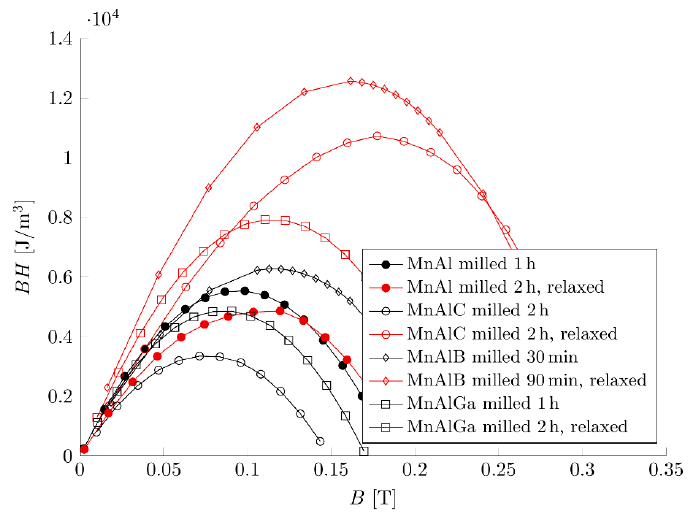
Figure 2. Energy product (BH) curves of MnAl and C-, B-, Ga-doped MnAl. The black lines are milled samples, and the red lines are milled and relaxed samples. Energies 2020 , 13 , x FOR PEER REVIEW